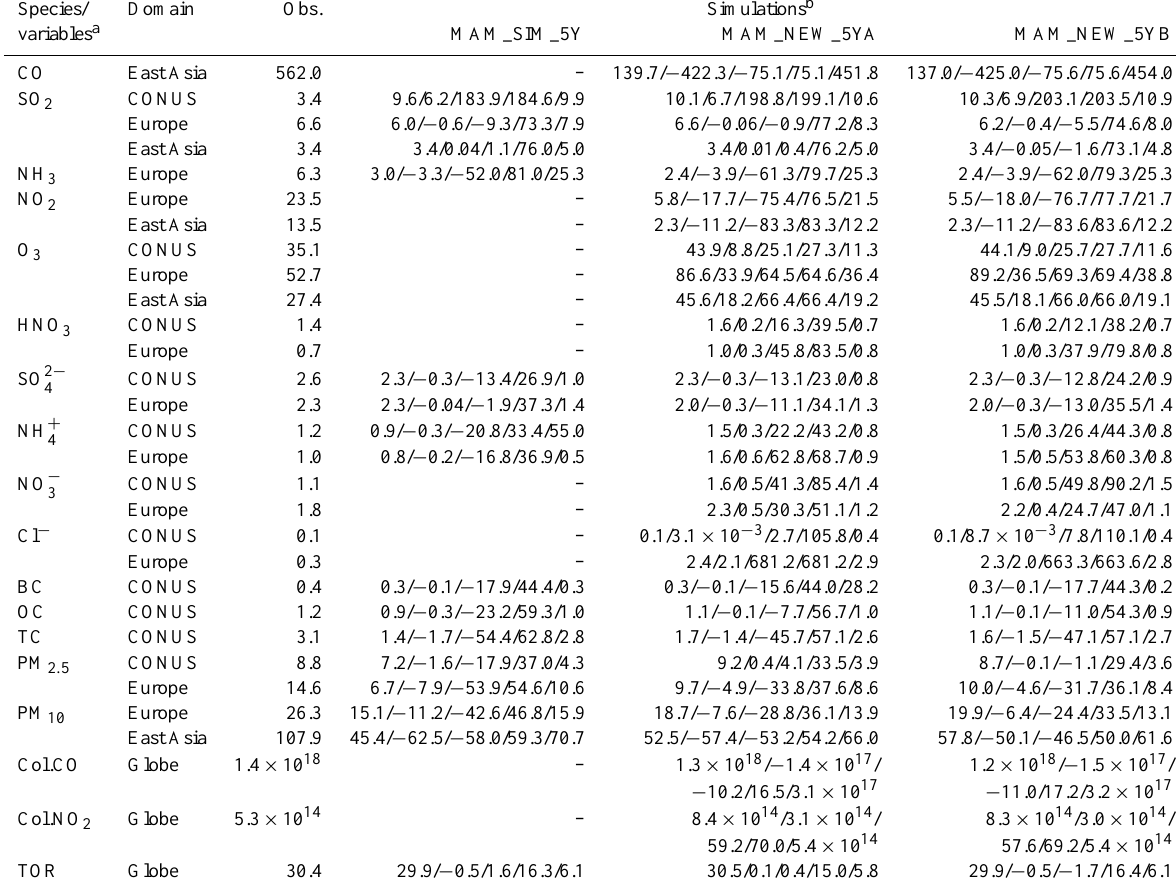
Table 6. Statistical Performance of Chemical Prediction (Average from the 2001–2005 Simulations). Species/